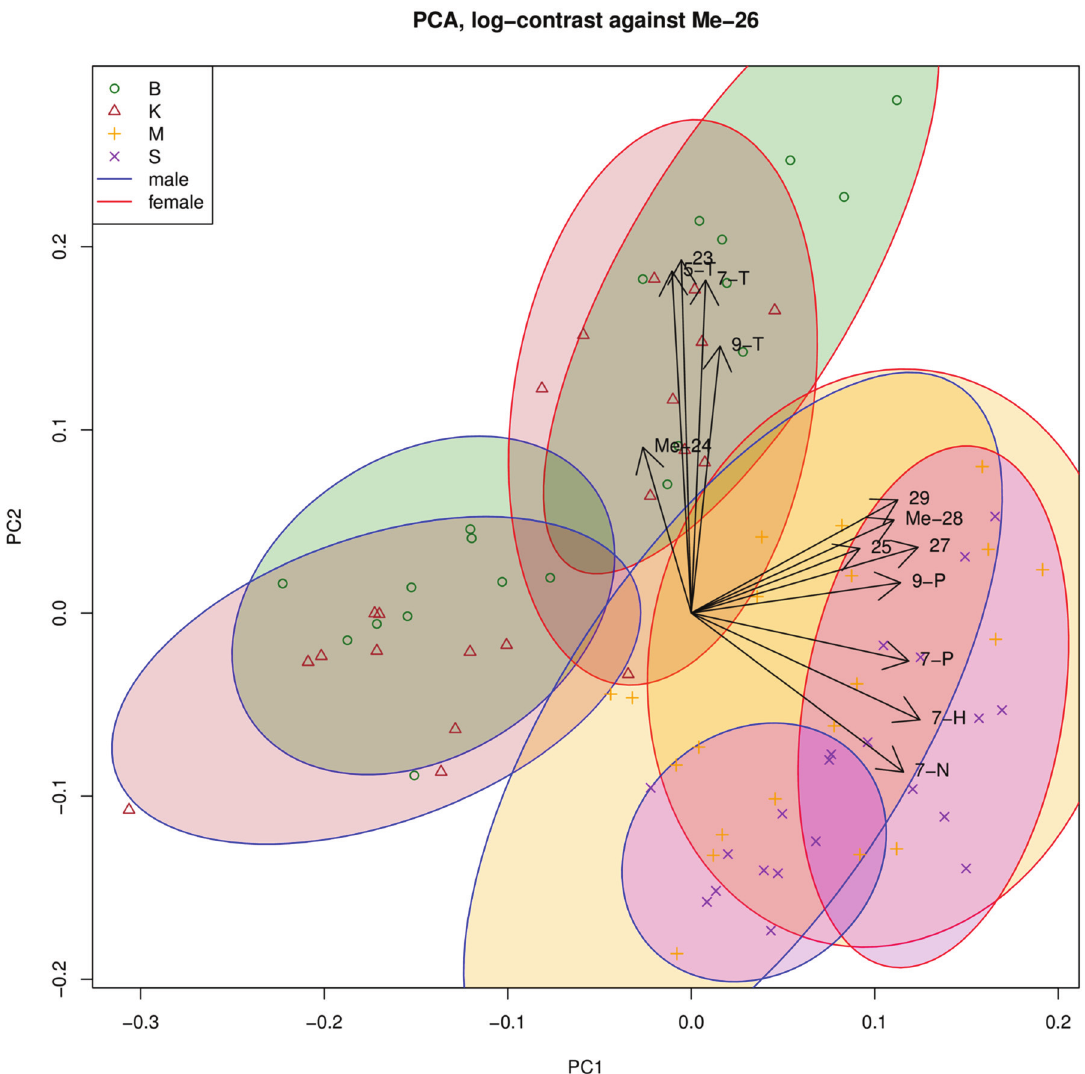
Figure 1. Principal component analysis of CHC compositions in the different populations.